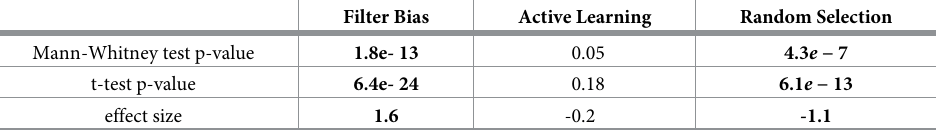
Table 8. Results of the Mann-Whitney U test and the t-test comparing boundary shift for the three forms of iter- ated algorithmic bias with class-dependent human action probability ratio 10:1. The effect size is calculated as ( Boundary | | )/ standard . dev . The negative effect size for filter bias shows that it decreases the num- t = 0 − Boundary t = 200 ber of points which are predicted to be in class y = 1. Random selection increases the number of points, while active learning does not have a significant